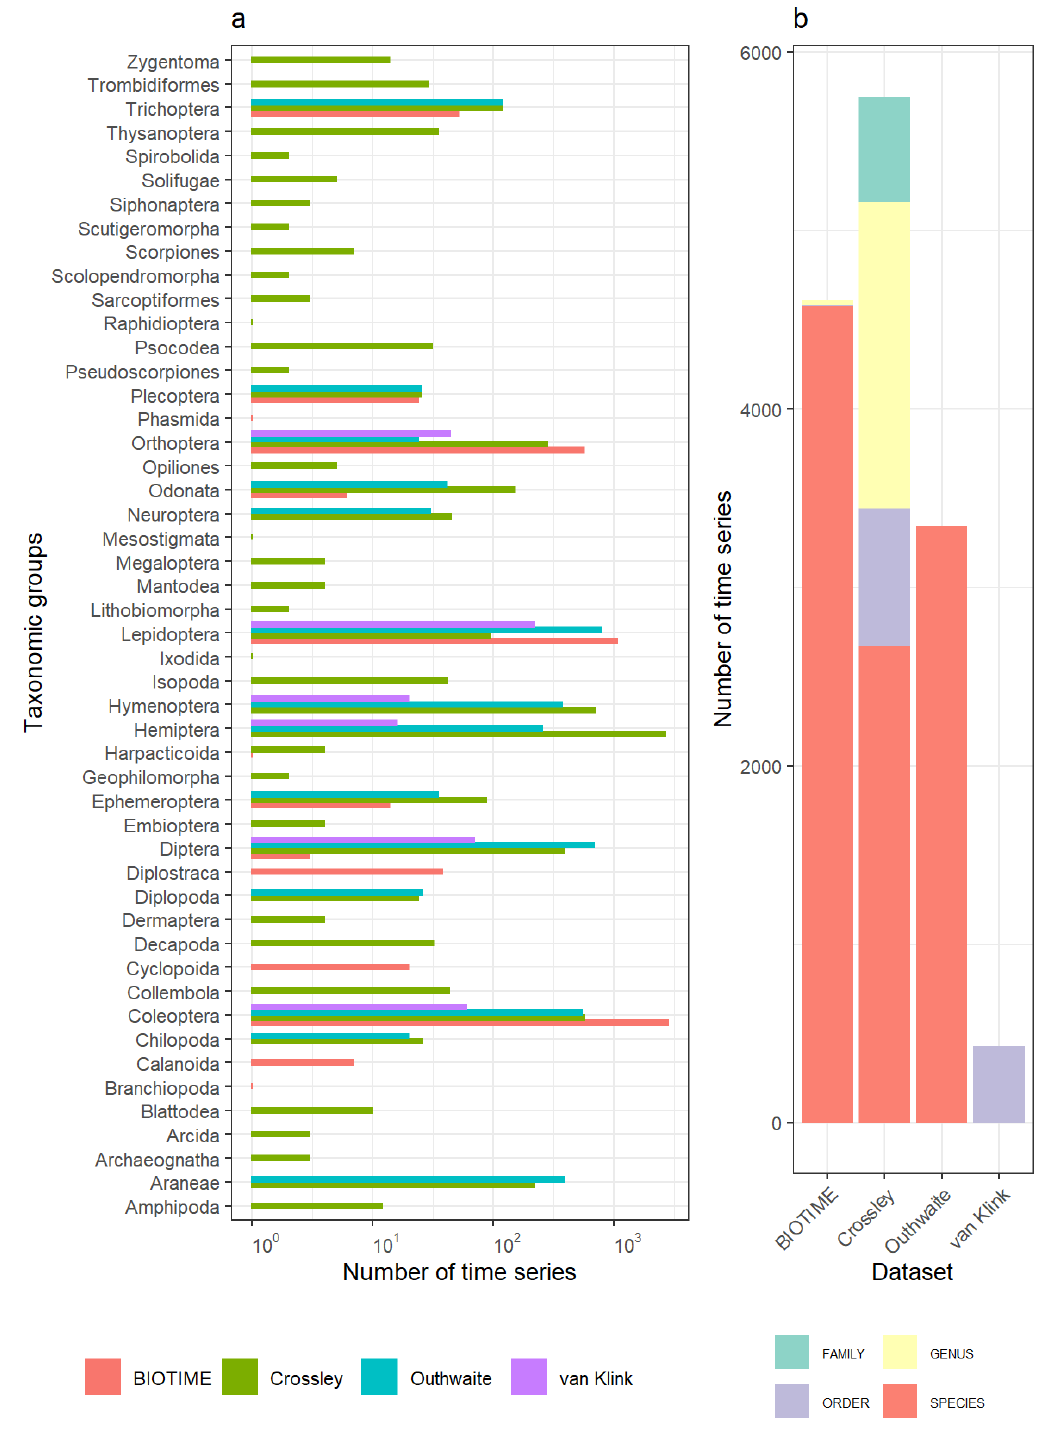
Figure S1: Taxonomic distribution of time series. (a) Number of species across taxonomic groups and (b) source datasets, as a function of their taxonomic